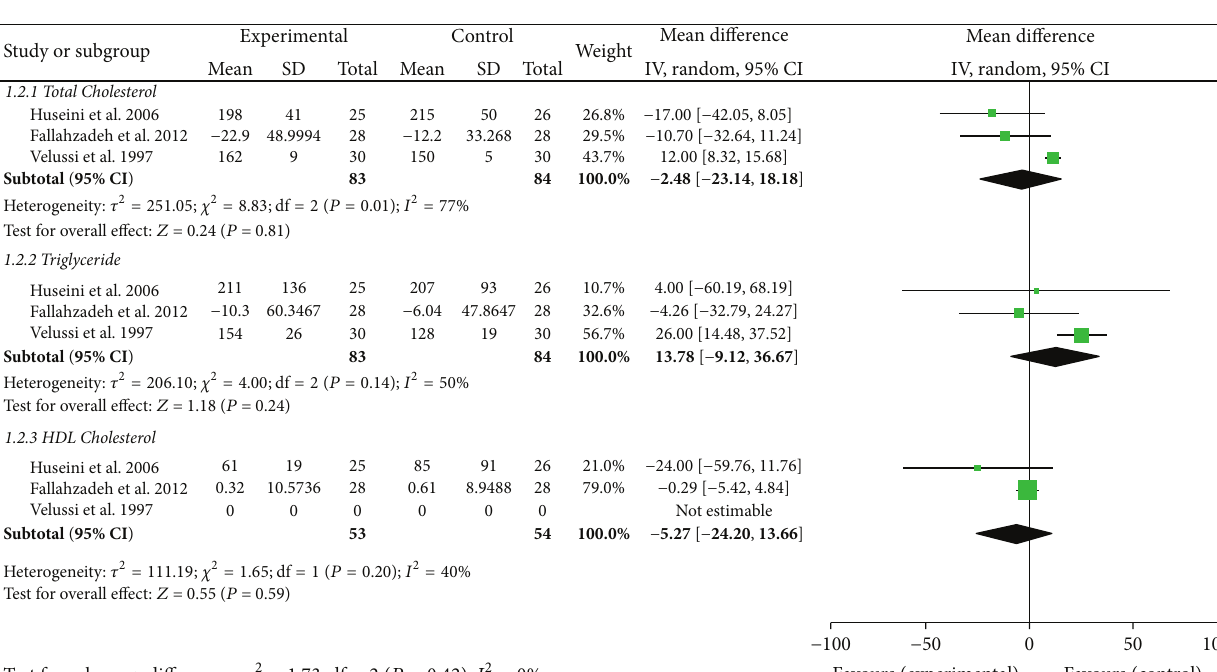
Figure 4: Glycemic control.